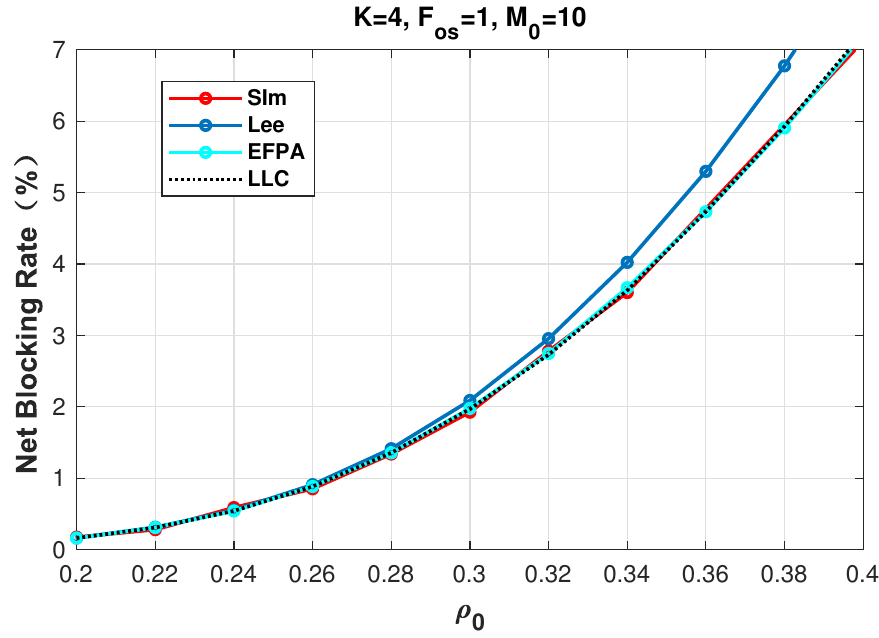
Figure 2. Network blocking performance of different methods with tree factor K = 4, over- subscription ratio F OS = 1, and sub-channel number in edge links M 0 = 10.